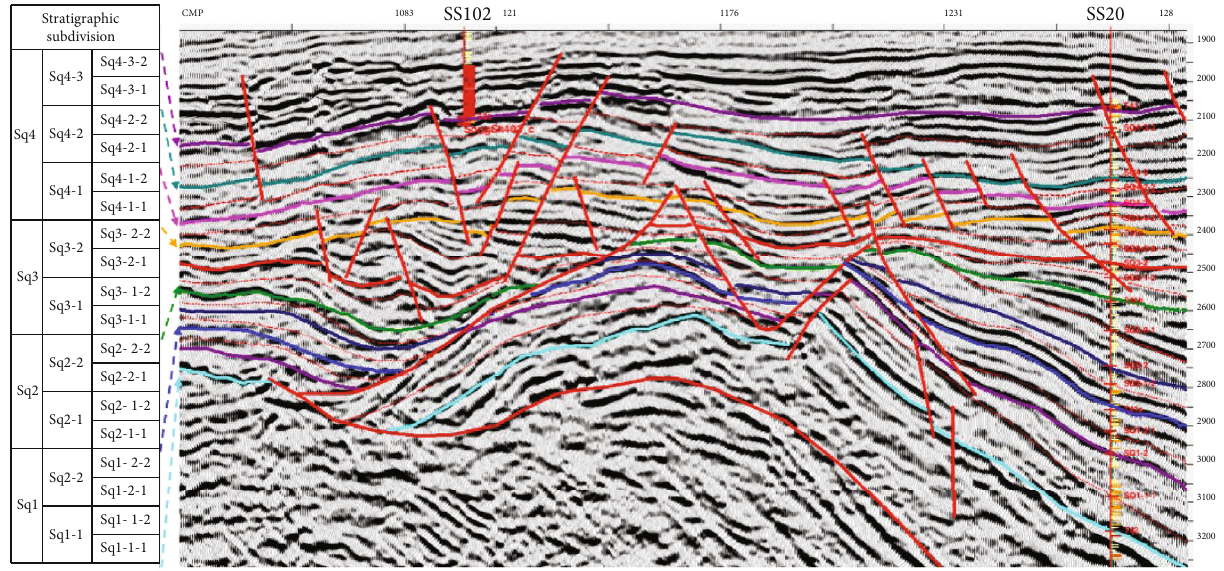
Figure 3: Seismic interpretation pro fi le of Shahe